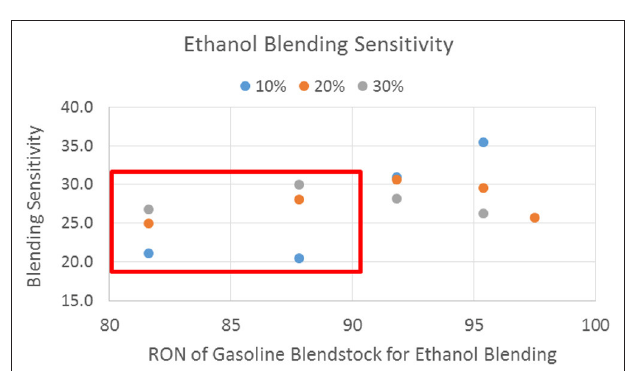
FIGURE 10 | The blending sensitivity of ethanol explored in this study was between 20 and 30 based on Anderson et al. (2012a) for gasoline blend stock with RON of about 80–90, and for subsequent blending with ethanol up to 30% by